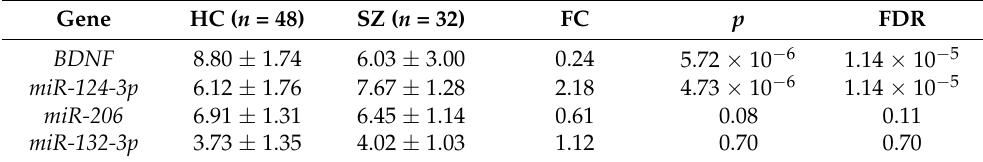
Table 2. Expression levels in healthy controls and in SZ patients.